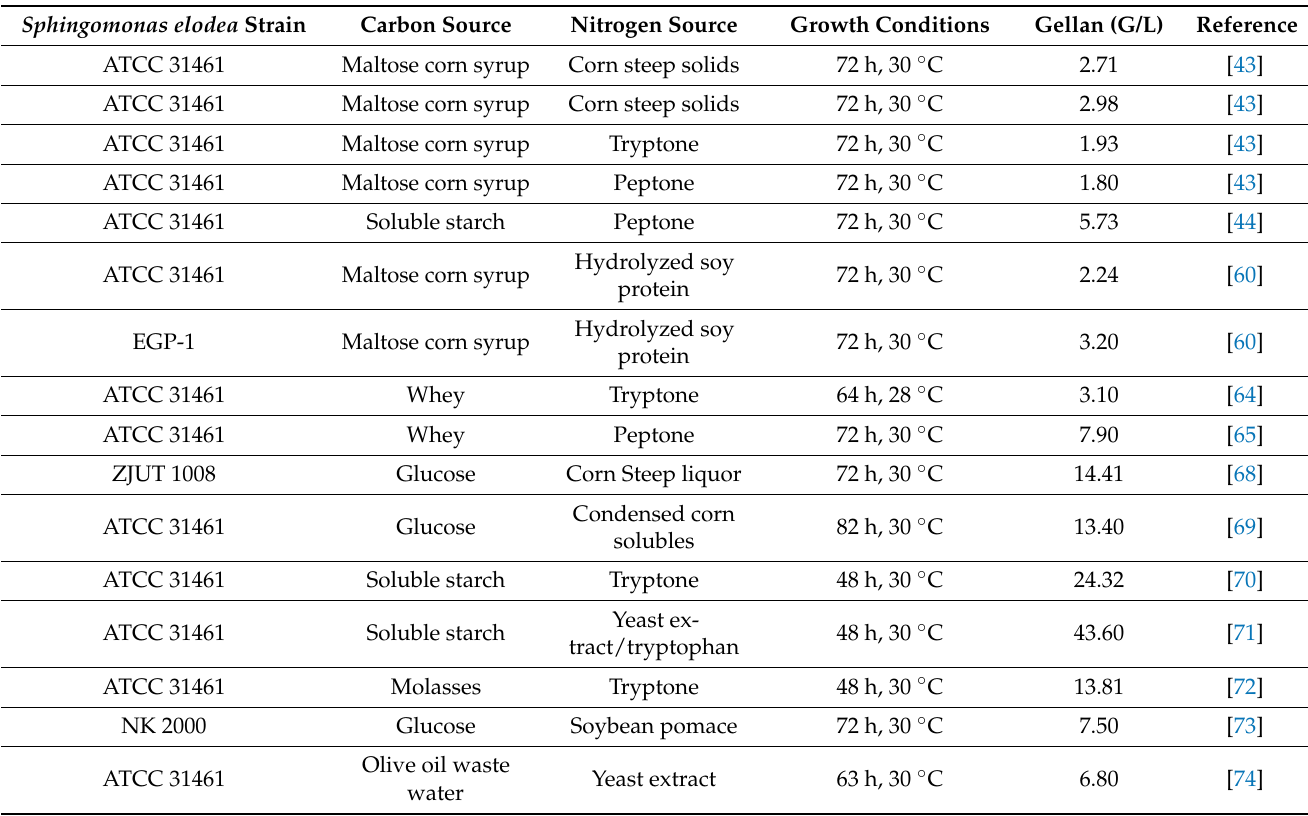
Table 1. Gellan production by strains grown on processing